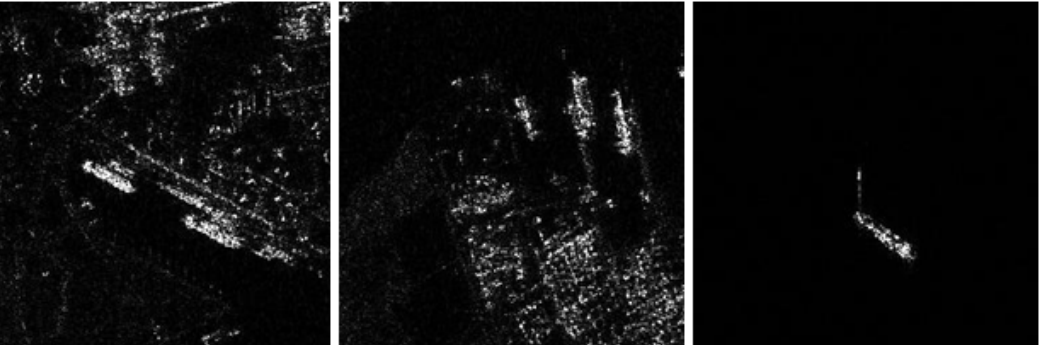
Figure 1. Some examples of the self-built dataset. The scene types include ports, islands and reefs, and sea surfaces with different levels of sea conditions. The targets cover thousands of ships in more than ten categories, such as transport ships, oil tankers, and fishing boats. than ten categories, such as transport ships, oil tankers, and fishing